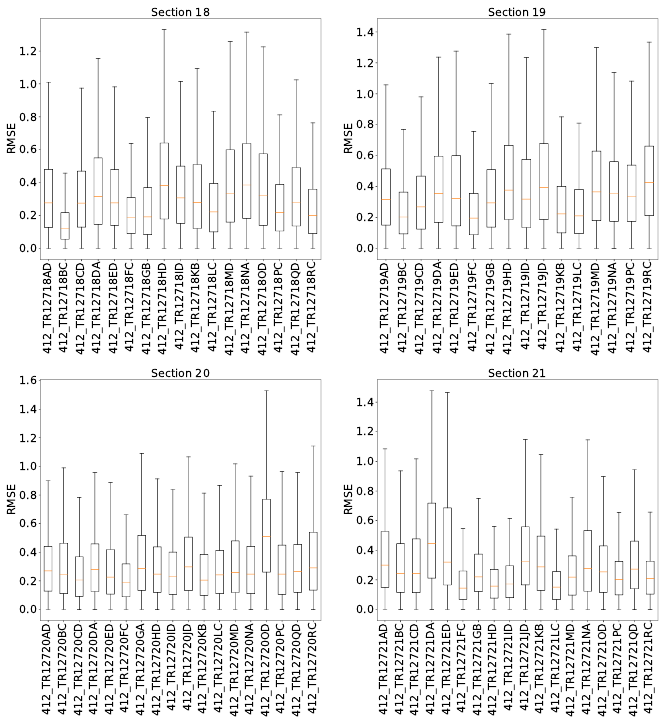
Figure 15. Absolute error analysis by each thermocouple in the test